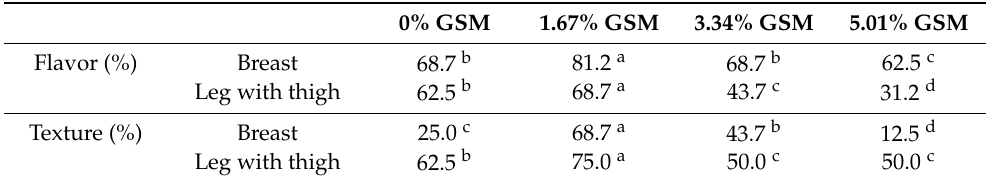
Table 5. Results of the sensory evaluation (flavor and texture) for the breast and leg with a thigh of broilers fed giant squid ( Dosidicus gigas ) meal in their diets.